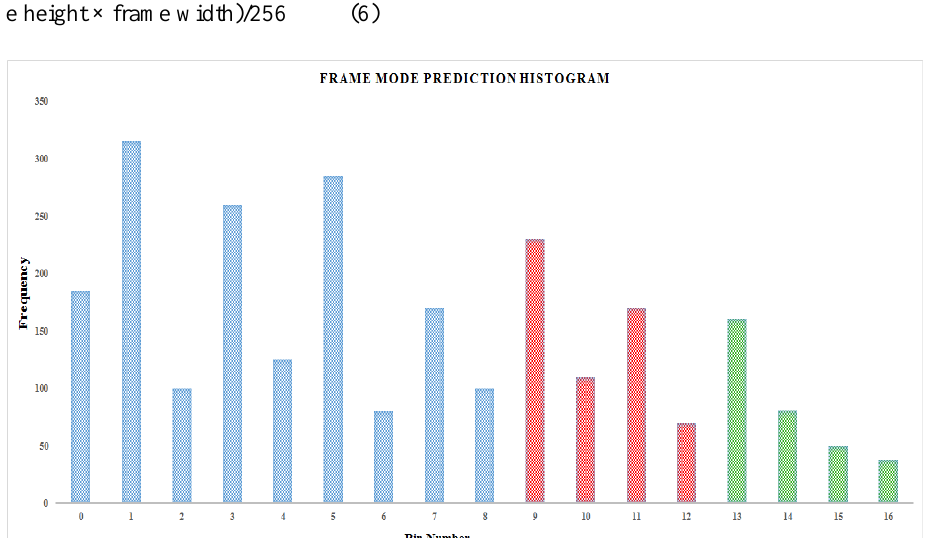
Figure 5. Frame feature vector - prediction modes